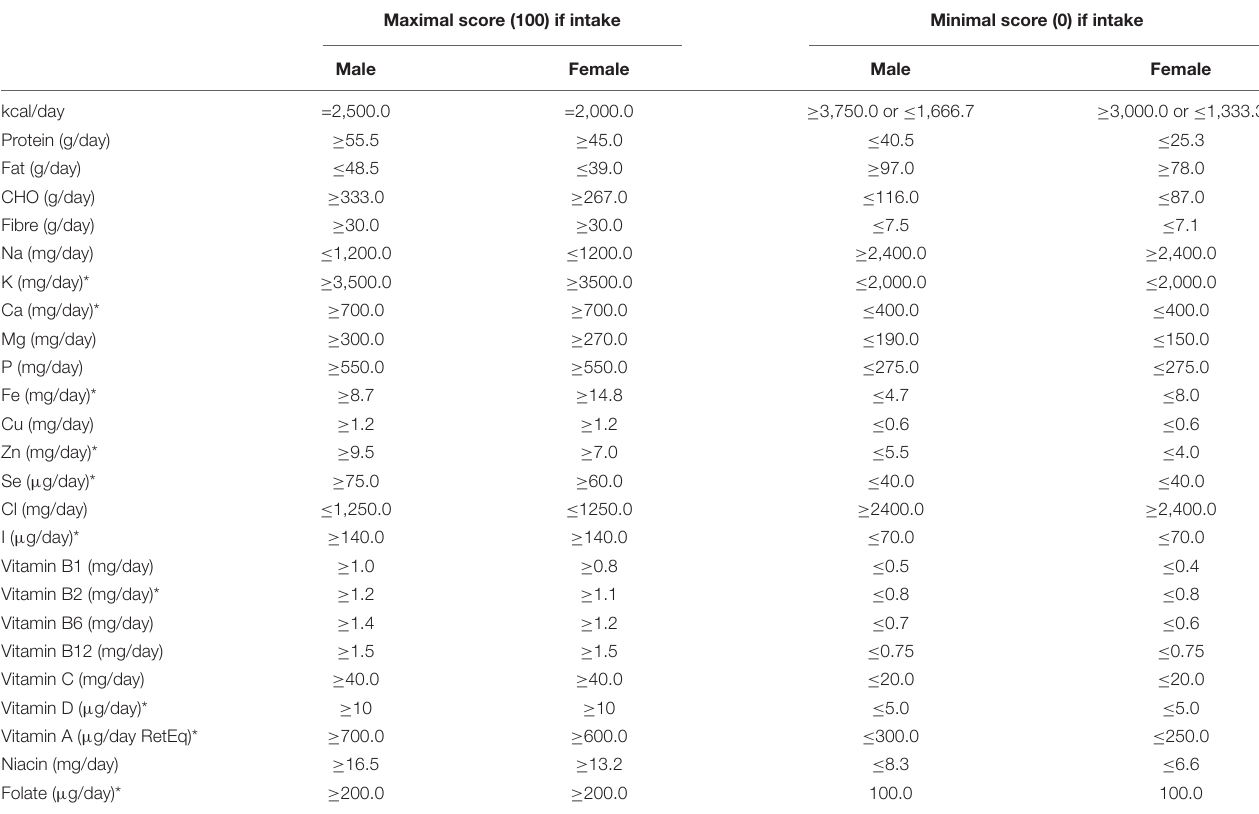
TABLE 1 | Approach to scoring component nutrient and energy intake and defining component adherence and total dietary adherence scores. Maximal score (100) if